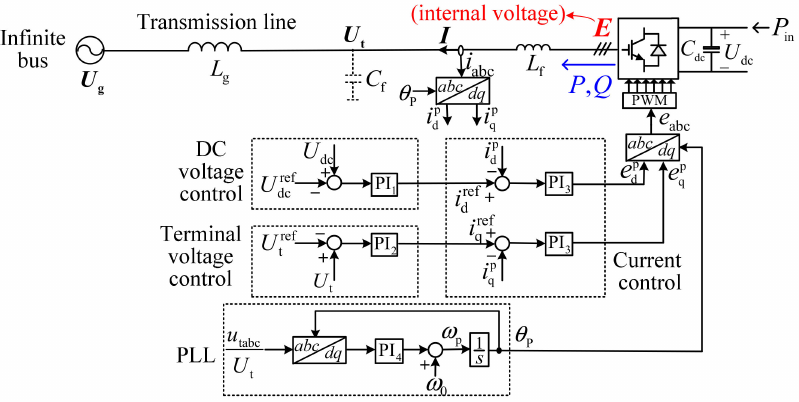
Figure 1. Typical diagram of a grid-connected voltage source converter (VSC) system. PI: Proportional-plus-integral; PWM: Pulse-width